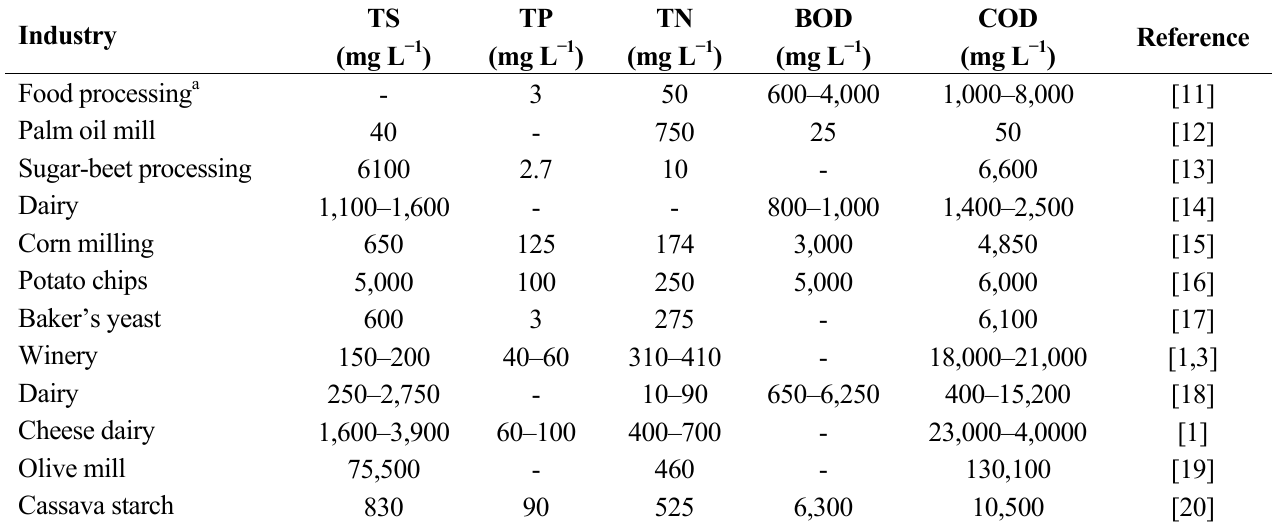
Table 1. Characteristics of typical agro-food industrial